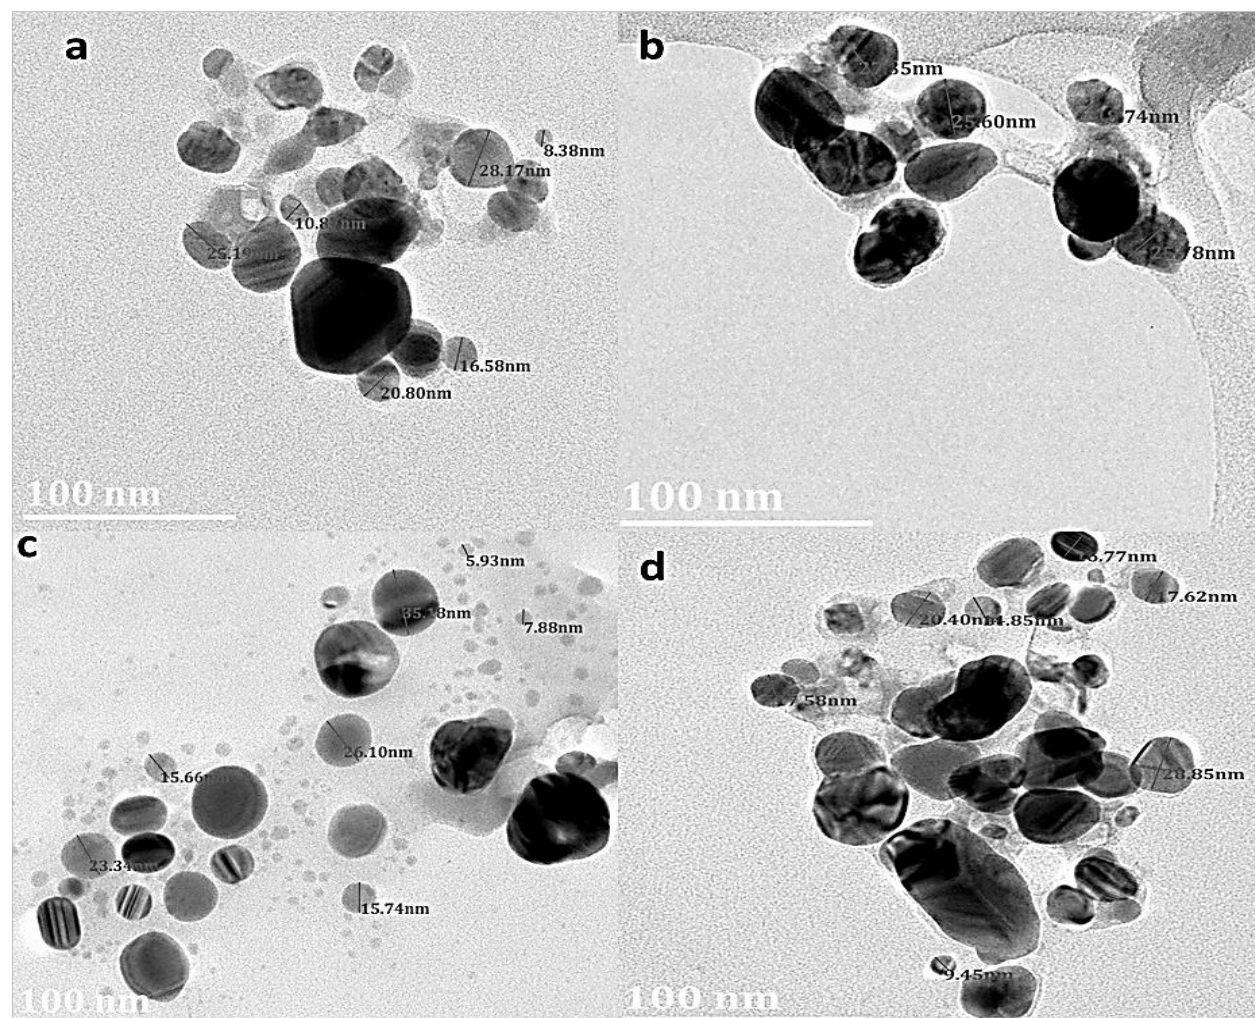
Figure 6. TEM images of D. villosa leaves AgNPs synthesized at room temperature (RT) ( a ) and at 80 °C ( c ); stem nanoparticles synthesized at RT ( b ) and at 80 °C ( d ), respectively.